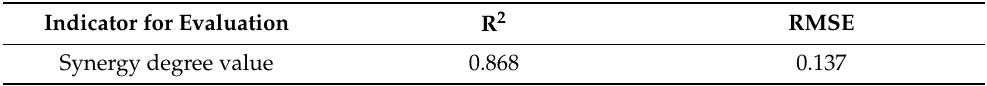
Figure 11. Comparison of actual data and simulated data from 2016 to 2020. Table 3. The metrics for evaluating the SD model.